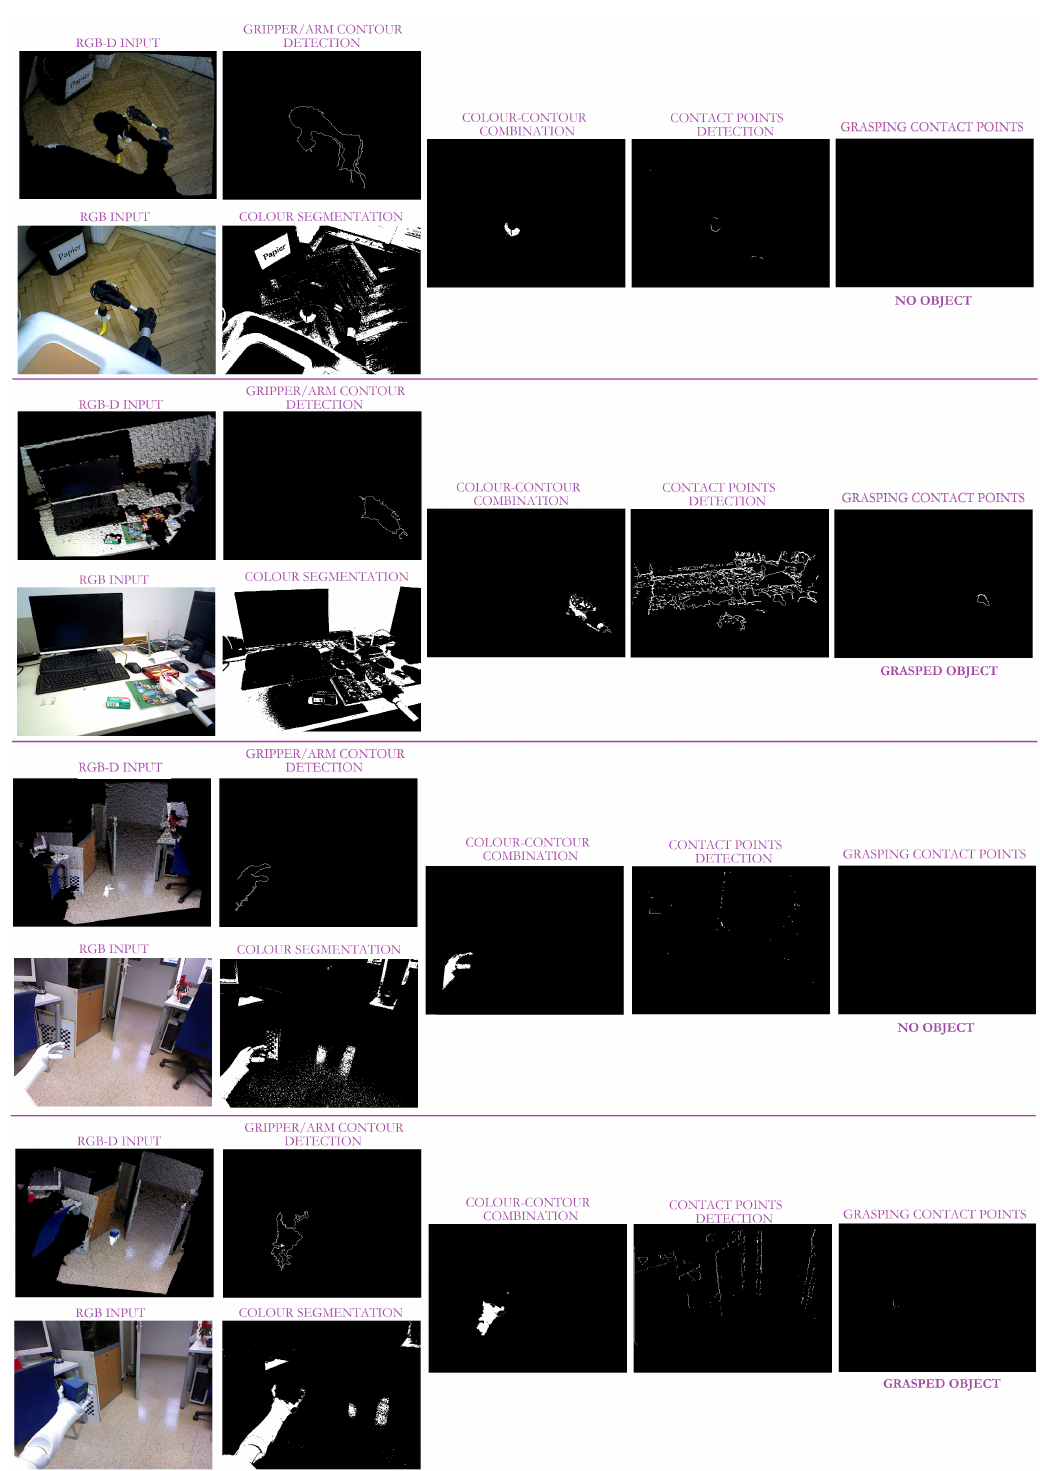
Figure 12. Some experimental results of our approach with the Hobbit and Pepper robots in assistive tasks. The first column corresponds to the taken RGB-D image given as an RGB image and a depth map. The second column illustrates the Lab segmentation with the robot arm contour obtained from the contour segmentation refinement. The third column illustrates the combination of the images in the two columns. The next column depicts all the two-object contact points based on depth proximity. The last image shows the contact points obtained from the overlap between the results in the third and fourth